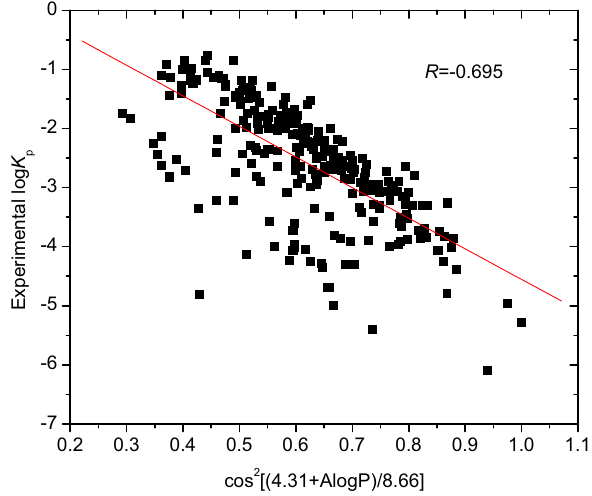
Figure 1. Plot of the descriptor cos 2 [(4.31 + A log P)/8.66] versus log K p , generated by OriginPro 7.5